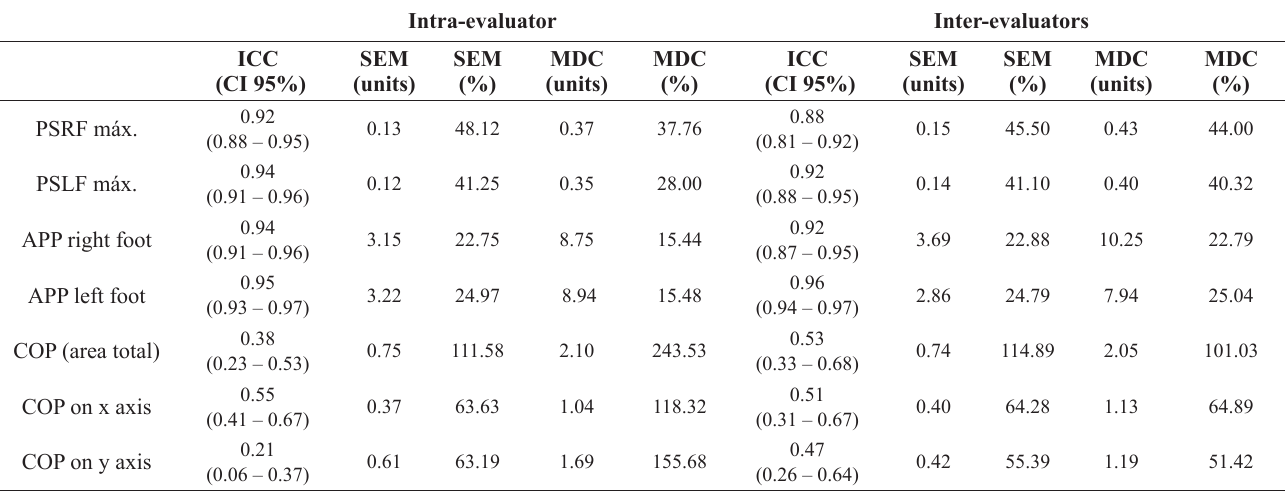
Table 5 - Intra and inter-evaluators reliability results for plantar pressure and stabilometry in children aged 8 to 12 years. Intra-evaluator